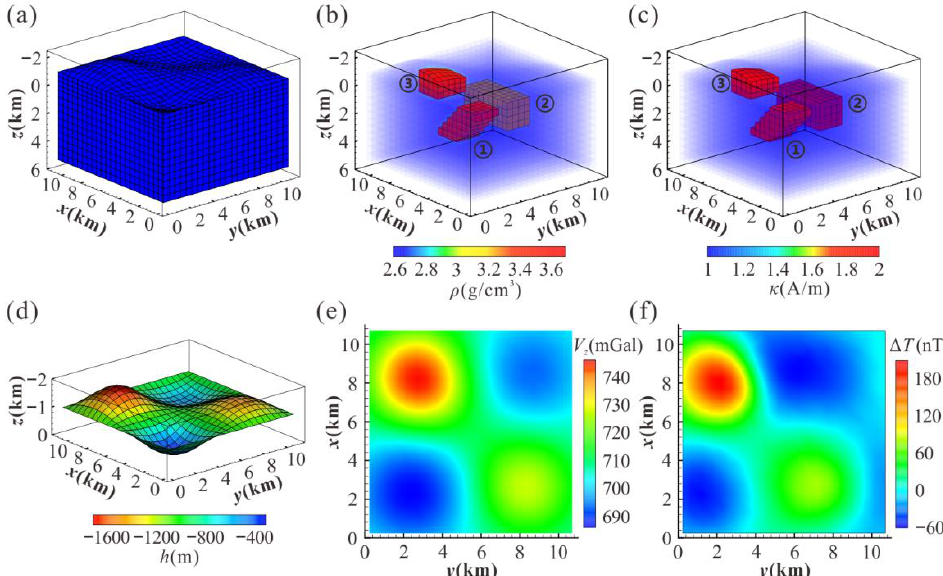
Figure 10. ( a ) Model division; ( b , c ) real density/magnetization model; ( d ) topographic relief; ( e , f ) observation data.